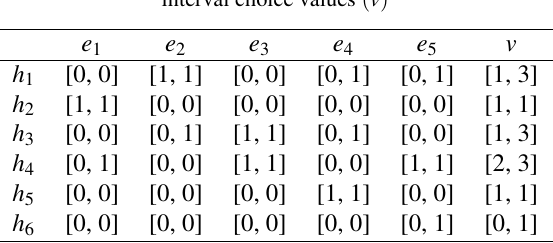
Table 3. An interval soft set ( F , A ) with interval choice values ( v )